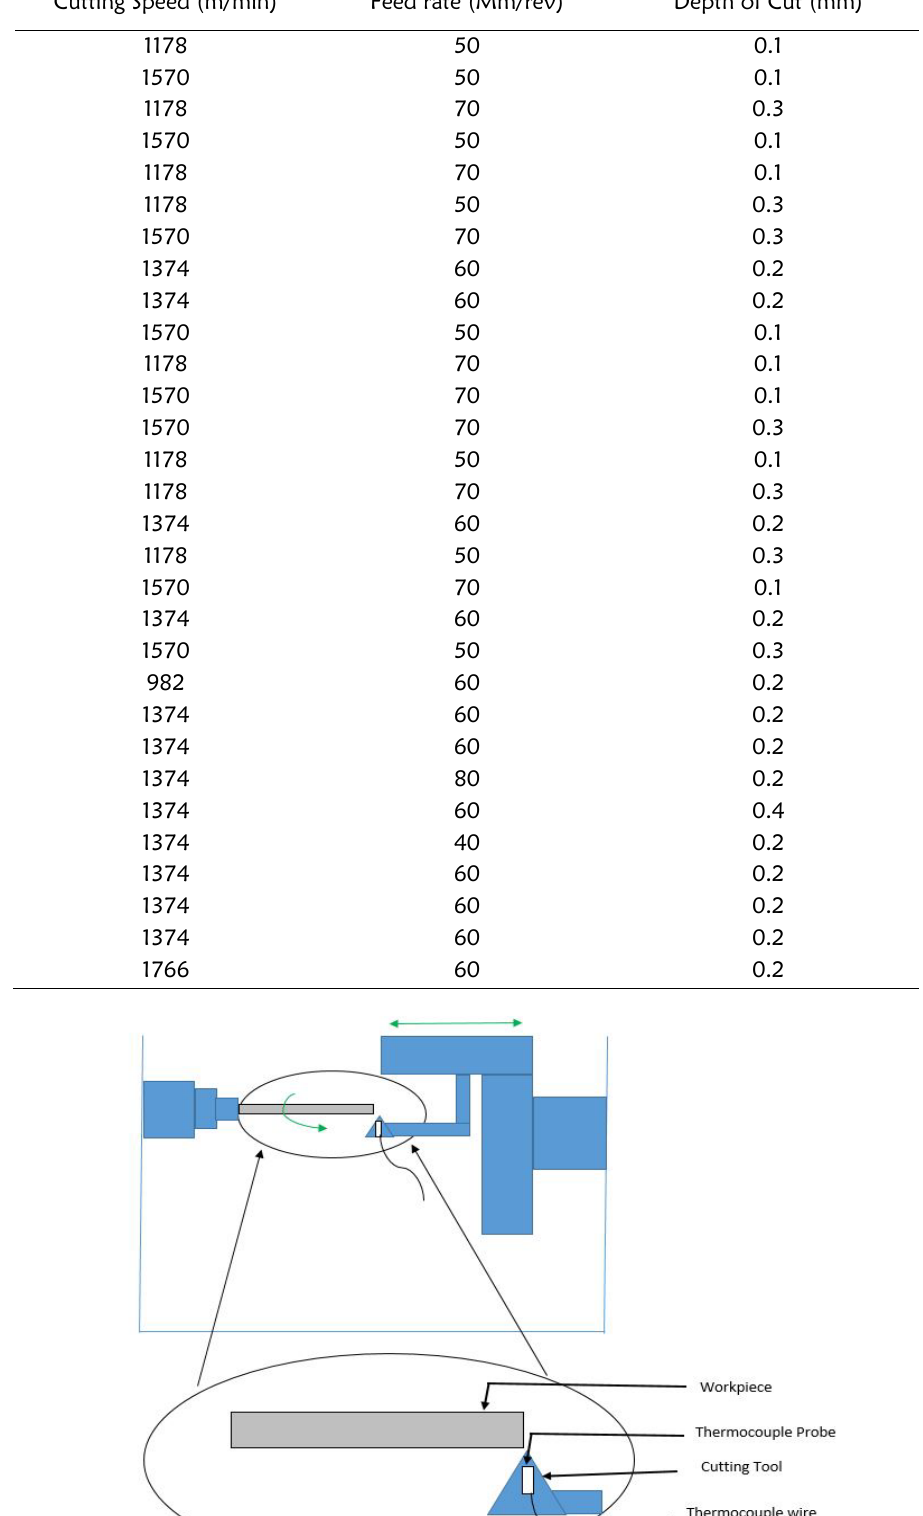
Table 3: Orthogonal Array for cooled machining from Design Expert